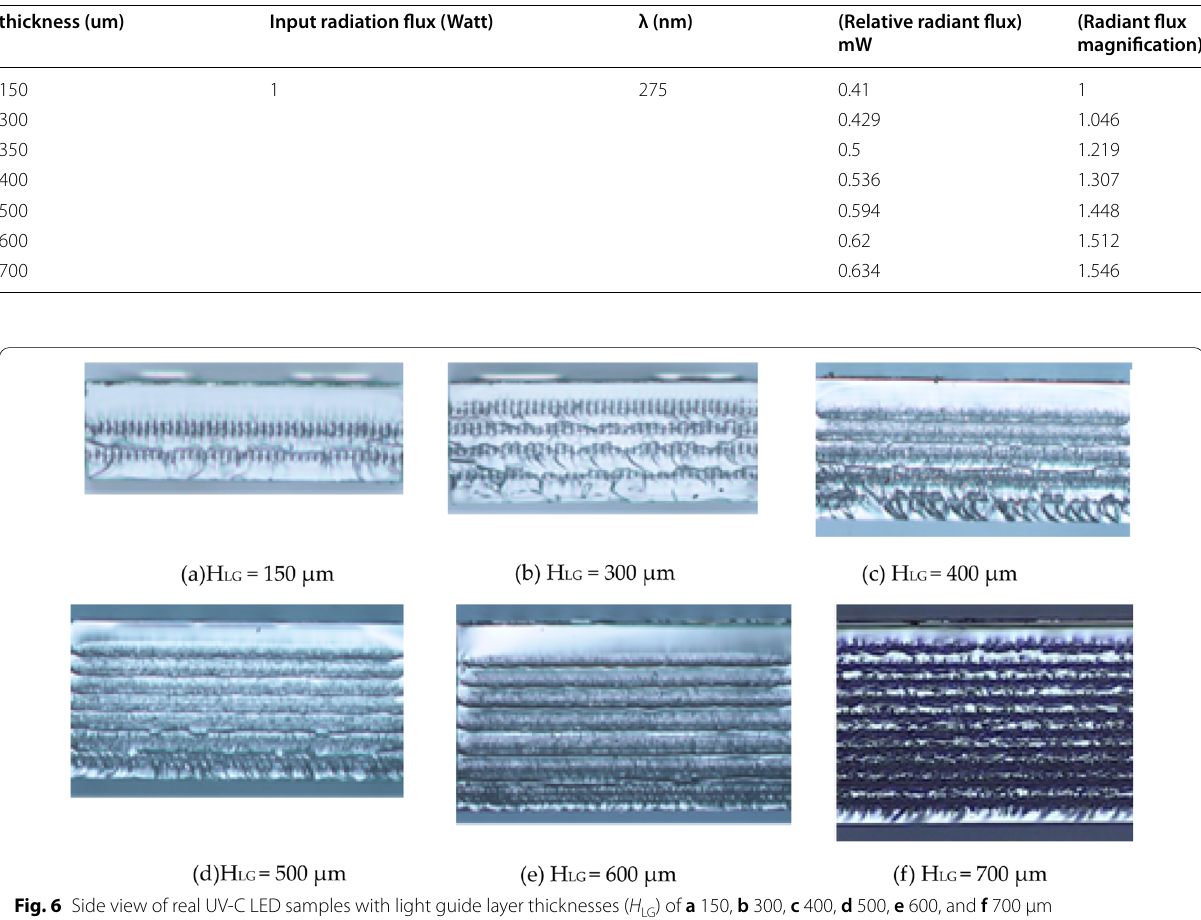
Table 3 LEE Results for light guide layer thicknesses of